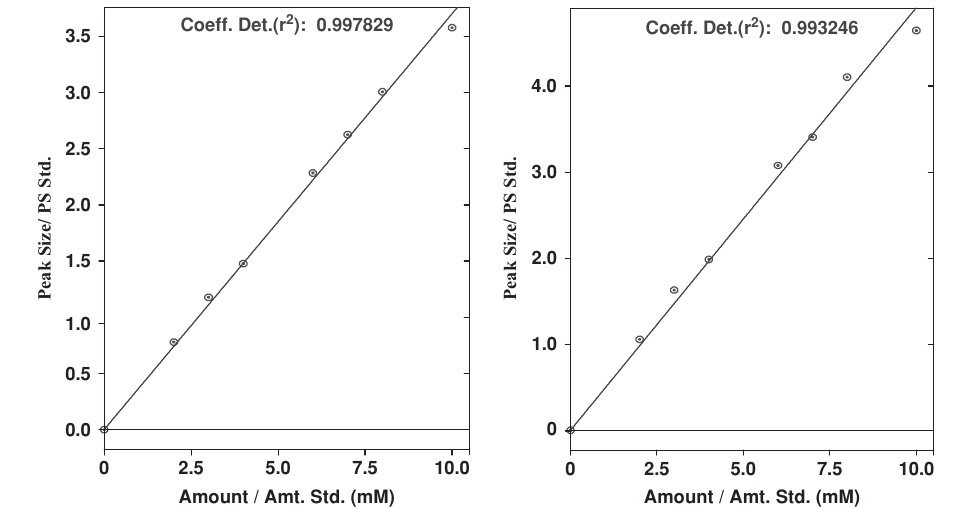
Figure 2 HPLC calibration curves for GDCA and TDCA measurements.